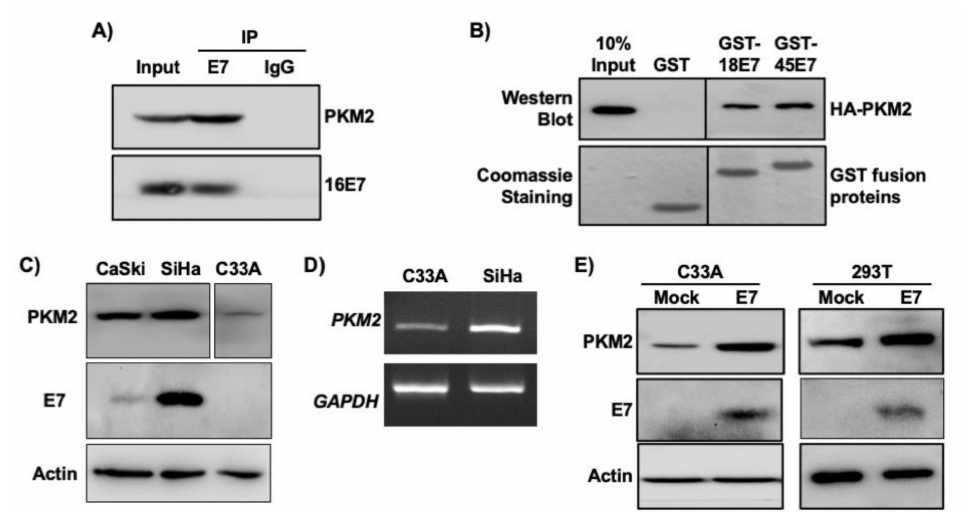
Figure 2. HPV16 E7 upregulates and interacts with PKM2 in cervical cancer cells. ( A ) HPV16 E7 interacts with PKM2 in SiHa cells. SiHa cell extracts (0.5 mg) were subject to co-immunoprecipitation using an anti-HPV16 E7 antibody. Normal IgG was used as a negative control. The input lane represents 50 µ g of cell extracts. ( B ) GST proteins fused to HPV18 E7 (GST-18E7) and HPV45 E7 (GST-45E7) were incubated with 293T cell extracts overexpressing HA-tagged PKM2 (HA-PKM2). GST was used as a negative control. PKM2 was detected by western blot using an anti-HA antibody. GST fusion proteins were visualized by Coomassie blue staining. Intervening lanes were deleted and indicated by vertical lines. ( C ) PKM2 levels were higher in HPV + than in HPV − cervical cancer cells. Cell extracts were subject to western blot. Intervening lanes were deleted and indicated by vertical lines. ( D ) The levels of PKM2 mRNA was higher in SiHa cells than C33A cells. Total RNA was subject to semi-quantitative RT-PCR. The number of PCR cycle was 25 for PKM2 and 22 for GAPDH . ( E ) HPV16 E7 increased the level of PKM2. Cells were transfected with an empty (mock) or HPV16 E7-expressing plasmid. Cell extracts were subject to western blot. Actin was used as a loading